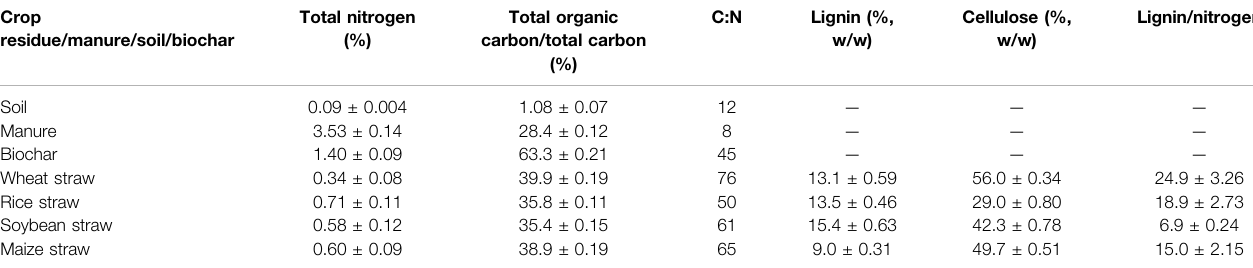
TABLE 1 | Selected chemical properties of the residues, biochar, manure, and soil used in this study. Crop residue/manure/soil/biochar